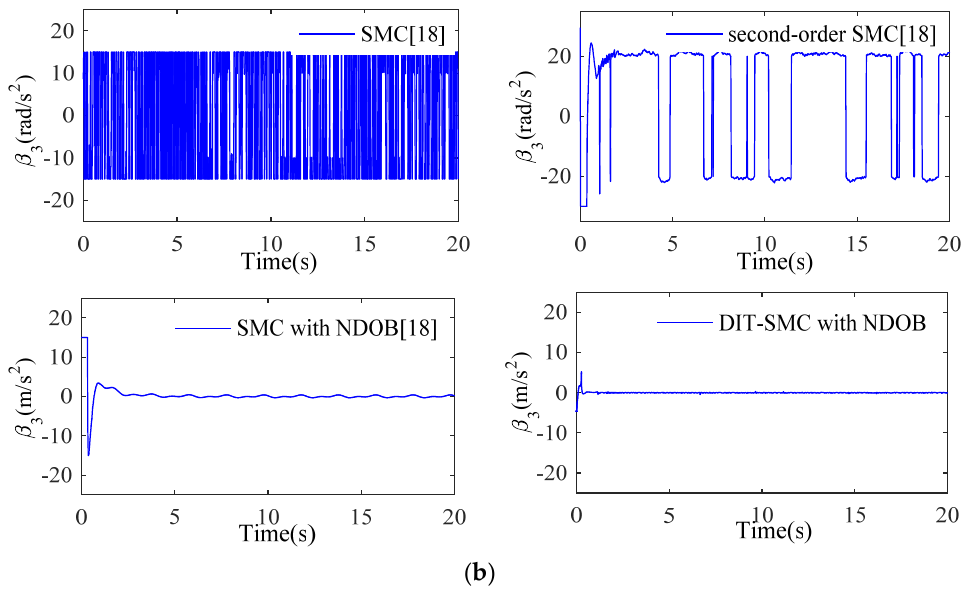
Figure 6. The acceleration and angular acceleration of follower robot 3; (a) α 3 ; (b) β 3.